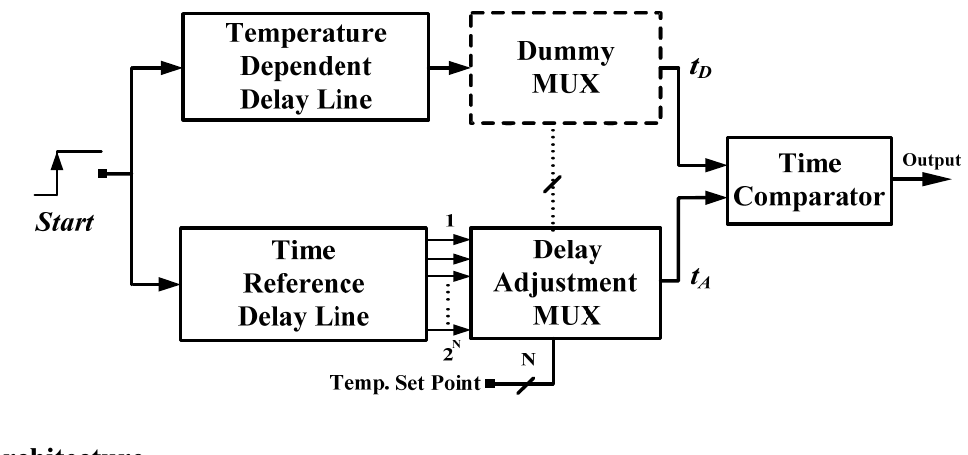
Figure 2. Block diagram of former time-domain